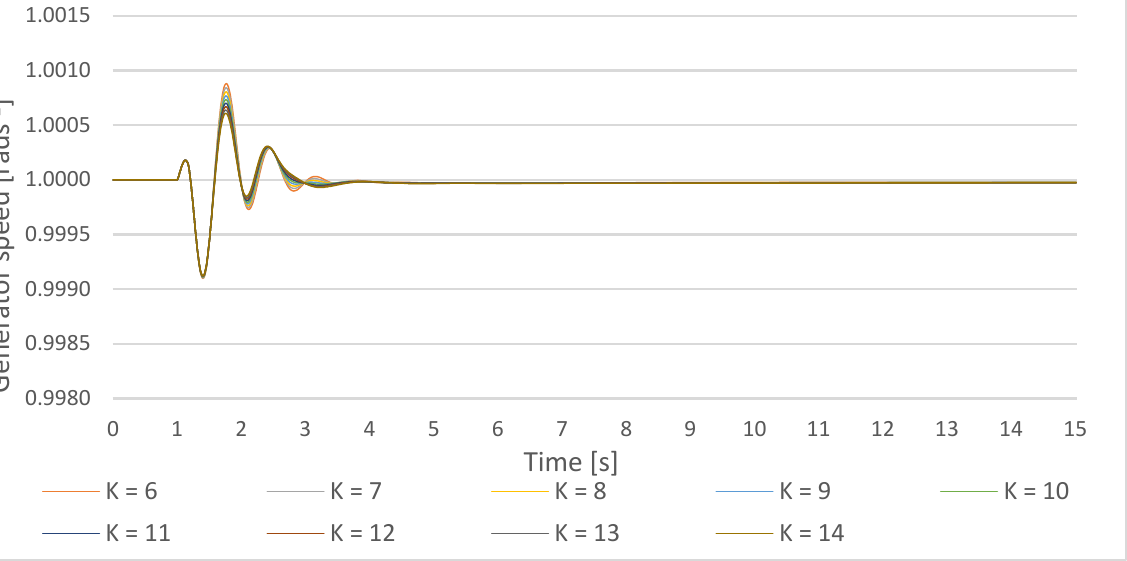
Figure 24. Gen1 speed response on a small disturbance with PSS parameters T = 0.5 s, the PSS gain increase in the lower cluster 1-K i,ln = 6–10, and the upper cluster 1 K i,um =